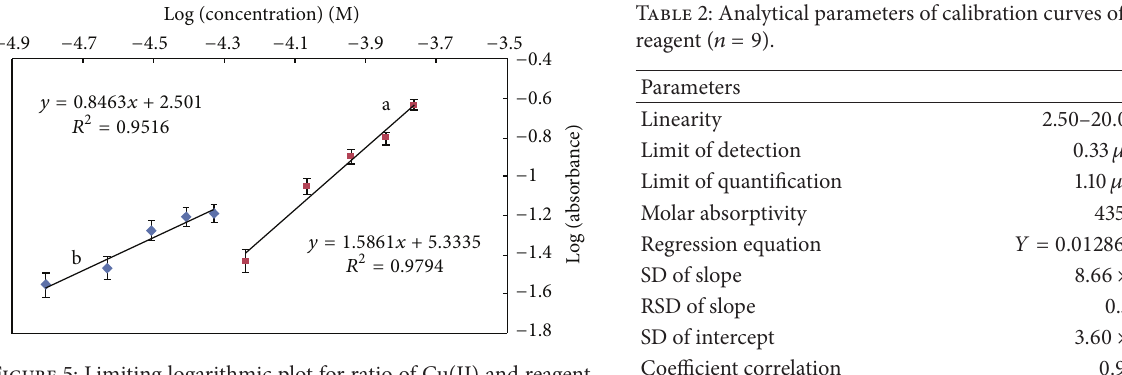
Figure 5: Limiting logarithmic plot for ratio of Cu(II) and reagent (MNDTT); (a) log abs versus log[MNDTT] and (b) log abs versus log [Cu].